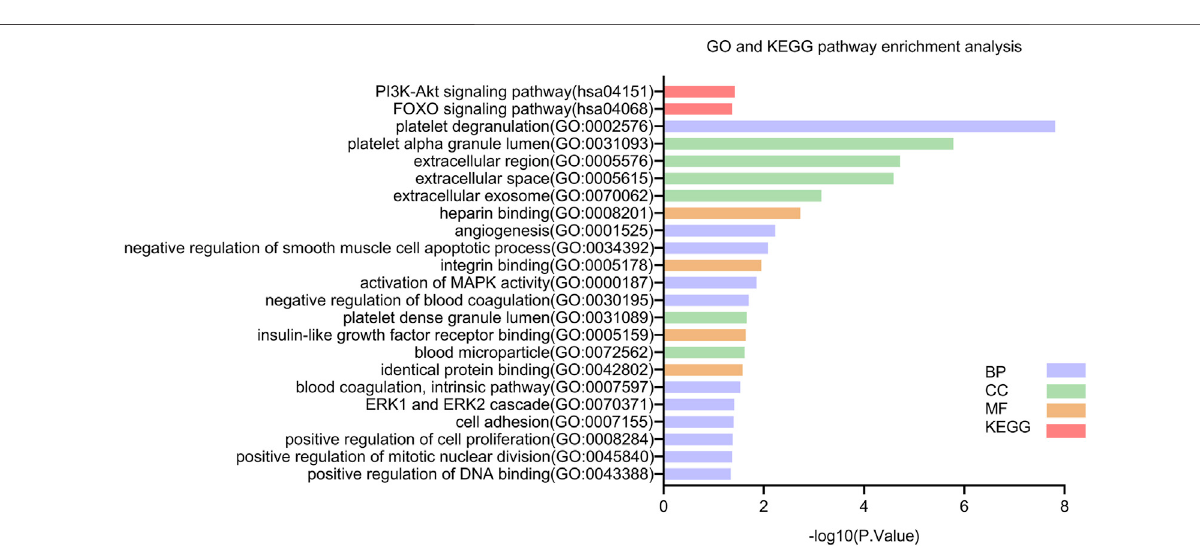
FIGURE 3 | KEGG and GO enrichment analyses of DEGs. Abbreviations: BP, biological process; CC, cellular component; MF, molecular function; DEGs, differential expression genes; GO, Gene Ontology; KEGG, Kyoto Encyclopedia of Genes and Genomes.